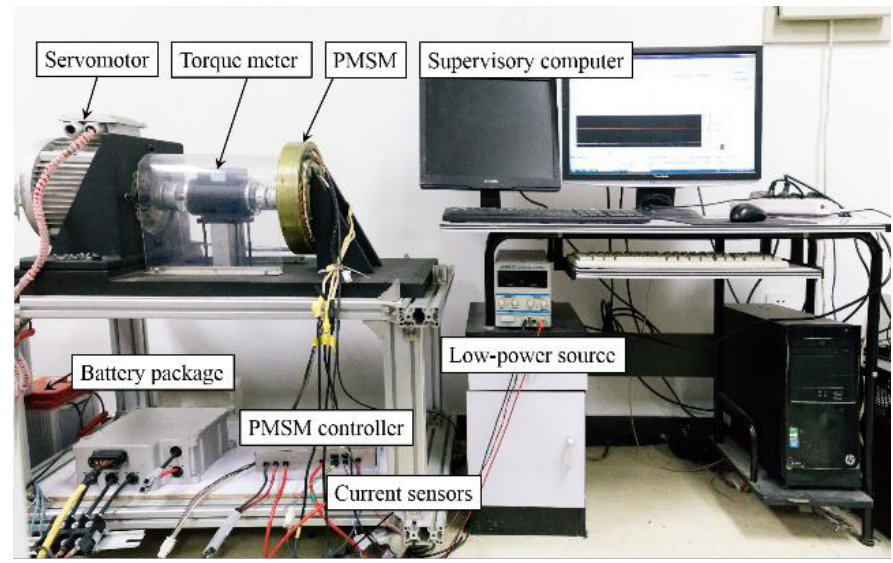
Figure 4. Experimental bench. PMSM: permanent magnet synchronous motor.